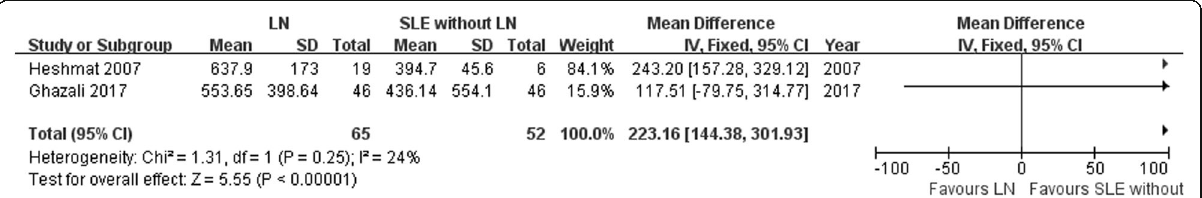
Fig. 3 Association of vascular endothelial growth factor protein levels with SLE developing into LN. SLE: systemic lupus erythematosus; LN: Lupus nephritis; SD: standard deviation; Total: the total number of SLE group or control group; CI: confidence intervals; I 2 : test the heterogeneity among recruited studies; df: degrees of